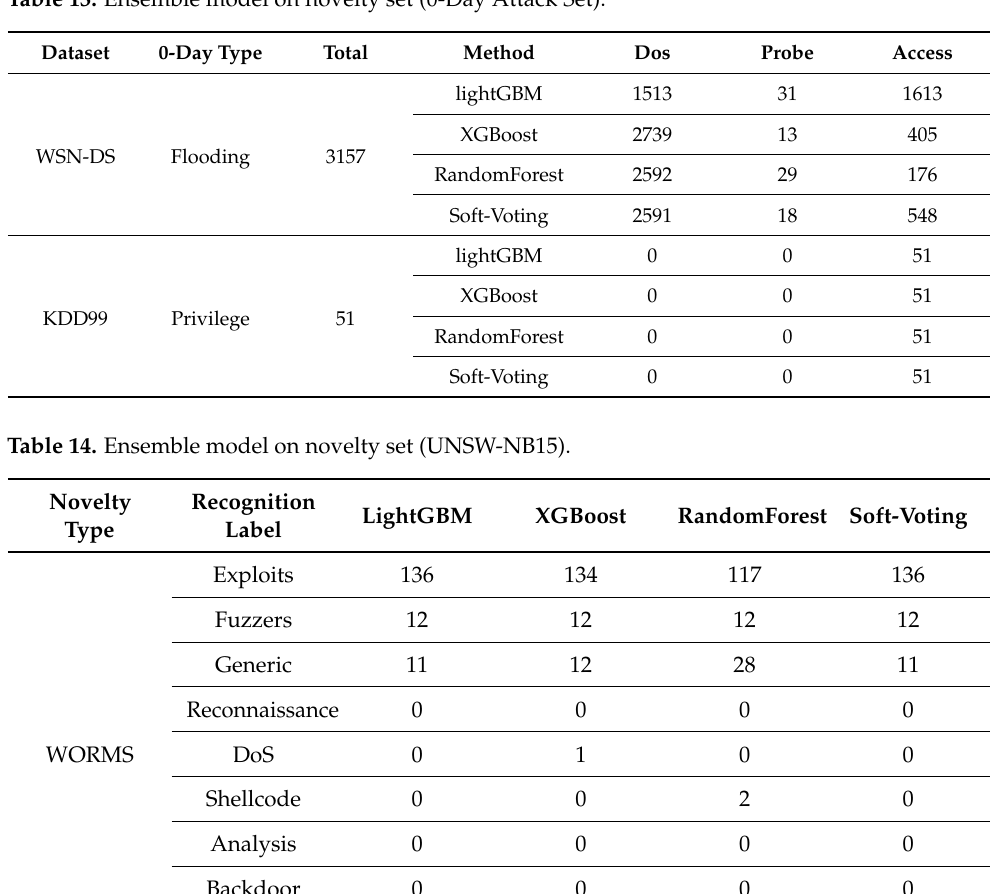
Table 13. Ensemble model on novelty set (0-Day Attack Set).